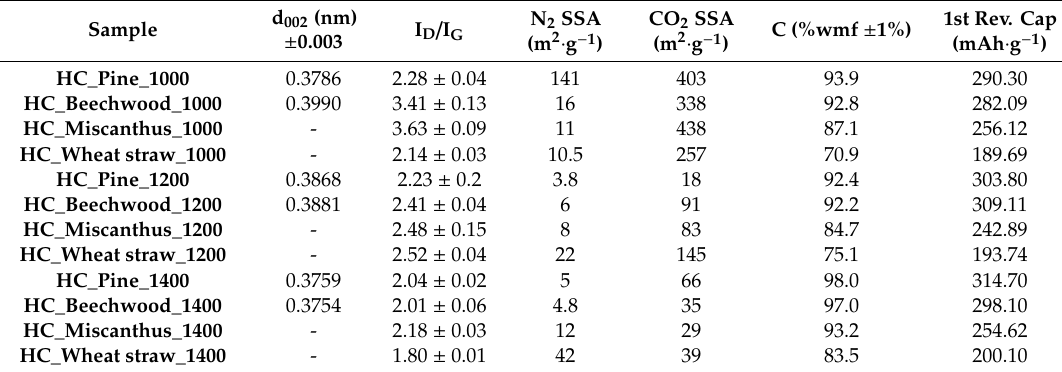
Table 2. Structural and textural properties of the obtained hard